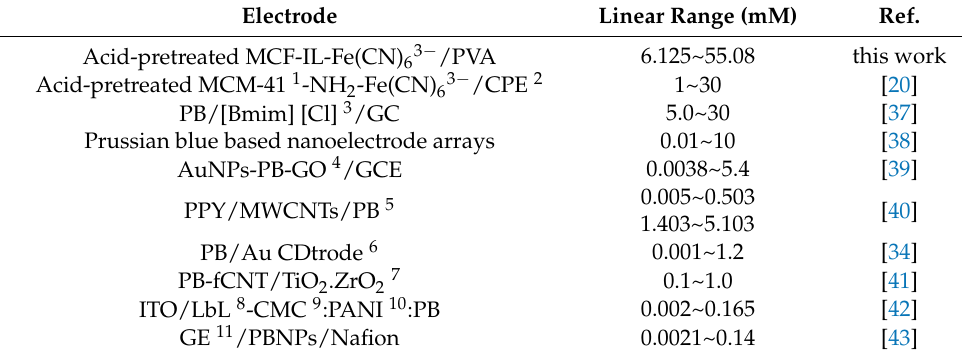
Table 1. Comparison of the sensing performance to H 2 O 2 for the PB modified electrodes in the